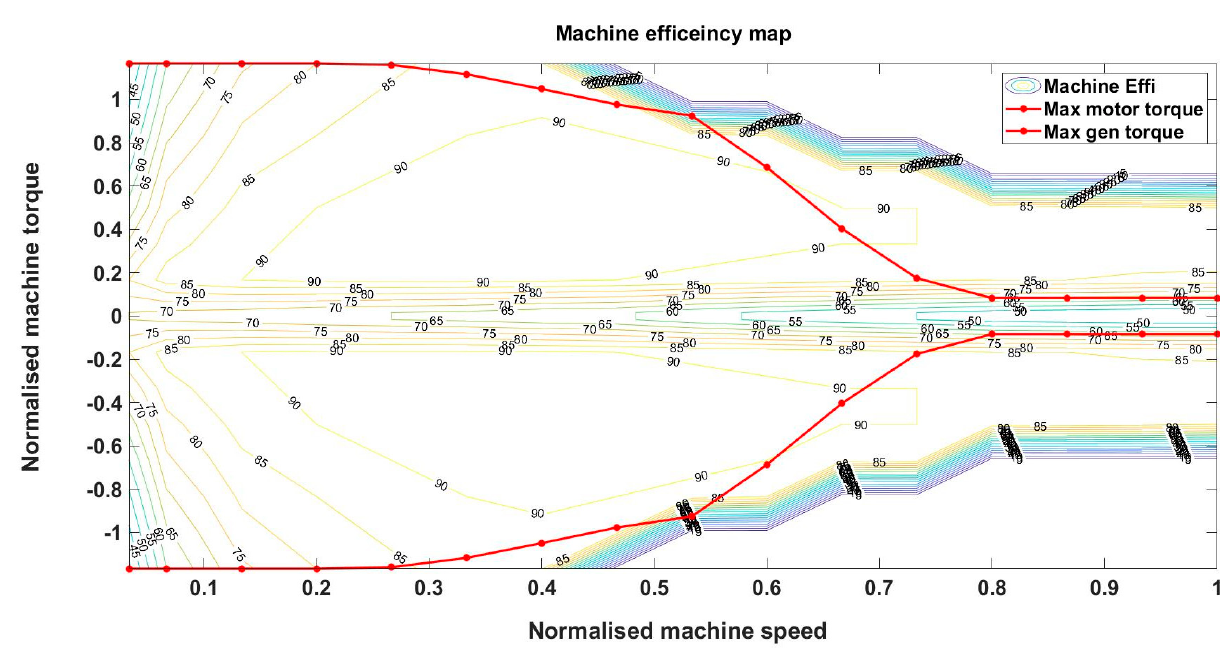
Figure 3. Efficiency map of the electric machine.